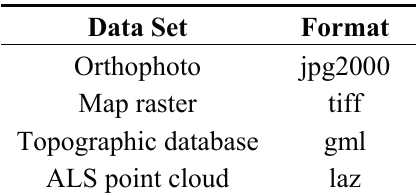
Table 1. The data sets